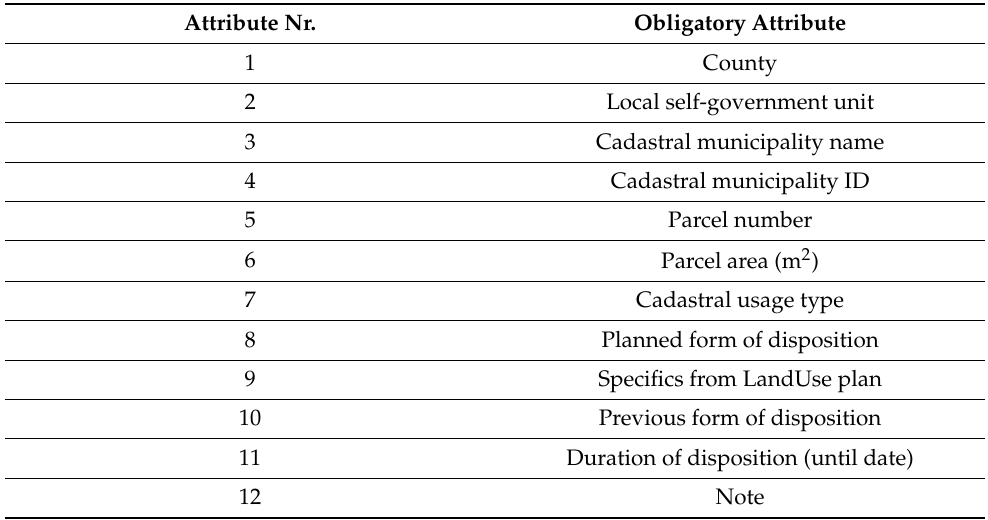
Table 1. The table form published by the Ministry of Agriculture which defines the necessary cadastral parcel